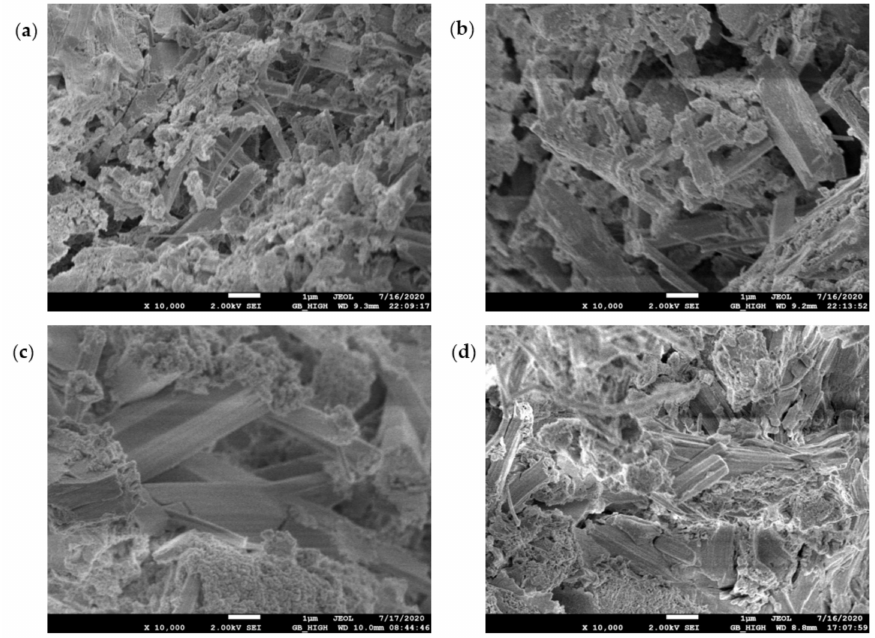
Figure 12. SEM diagram of pure cement paste (FA replacement ratio is 0%) at 28 days of age: ( a ) pH = 7.6 OW; ( b ) pH = 9.5 AEW; ( c ) pH = 10.5 AEW; ( d ) pH = 11.5